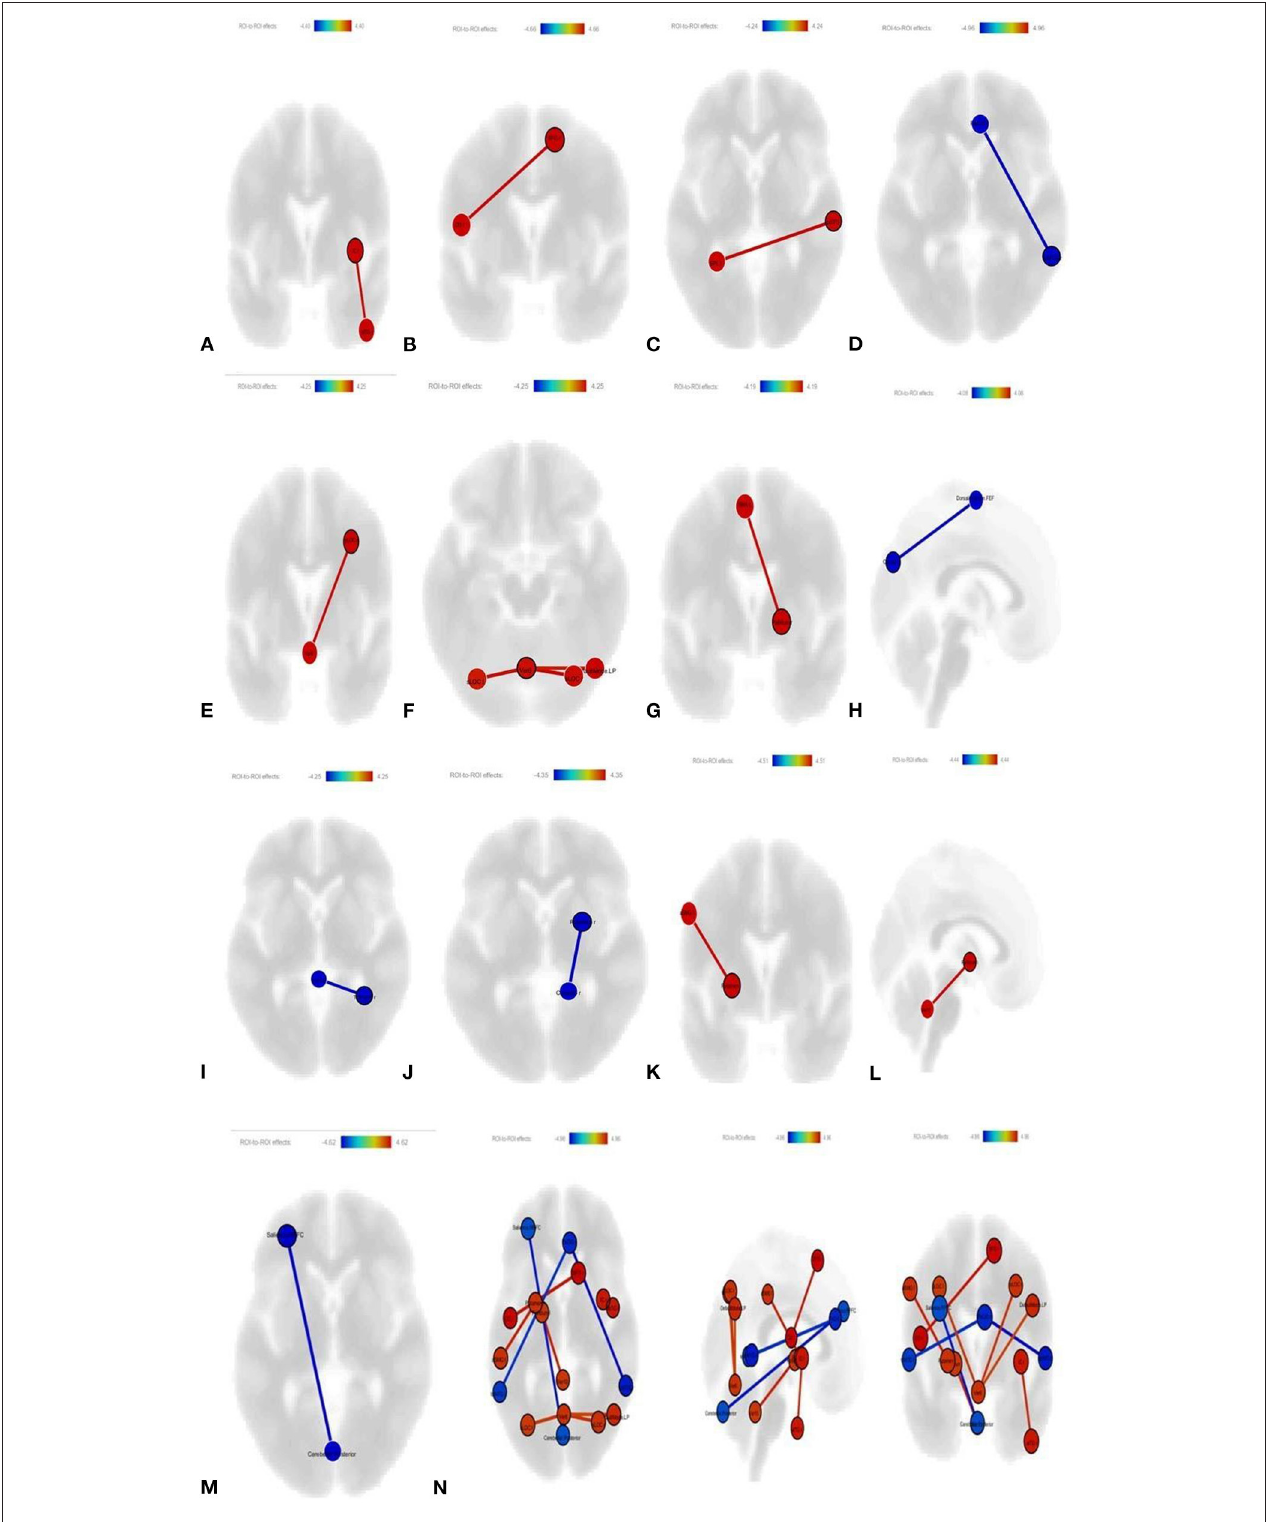
FIGURE 3 | (A) Increased connectivity between right IC and right anterior ITG increased ( p- unc: 0.0003; p- FDR: 0.224); (B) increased connectivity between right superior frontal gyrus (SFG) and the left COC ( p- unc: 0.0002; p- FDR: 0.0125); (C) increased connectivity between right posterior STG and left SPL ( p- unc: